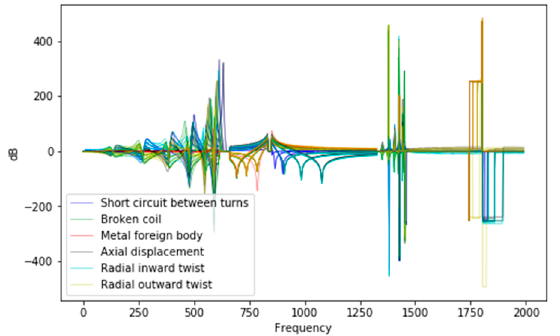
Figure 6. Feature vectors distribution of different fault types.